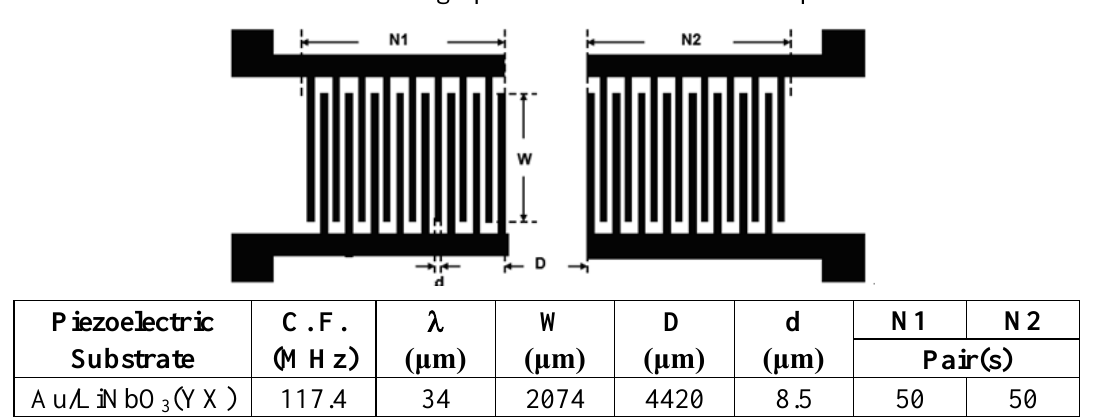
Table 1. Design parameters of the SAW